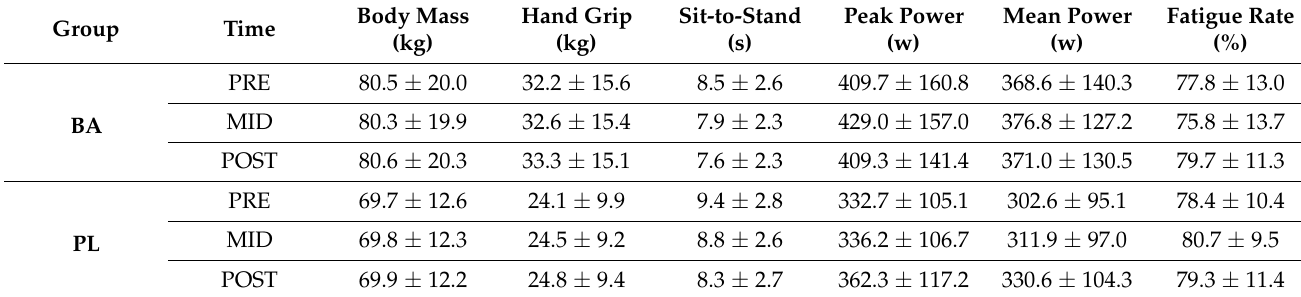
Table 2. Performance